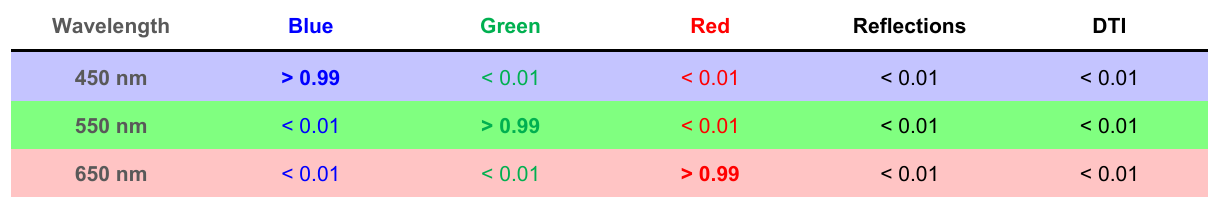
Table  : Subwavelength Bayer RGB color router with perfect optical ef fi ciency for the R, G, B color channels (bold values) and with no crosstalk, no re fl ections and no light leaking into non-photosensitive DTI regions. Wavelength